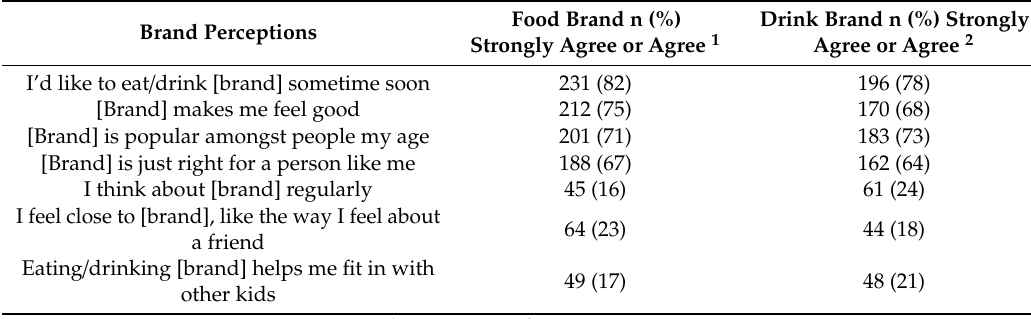
Table 1. Brand attachment for favourite food and drink